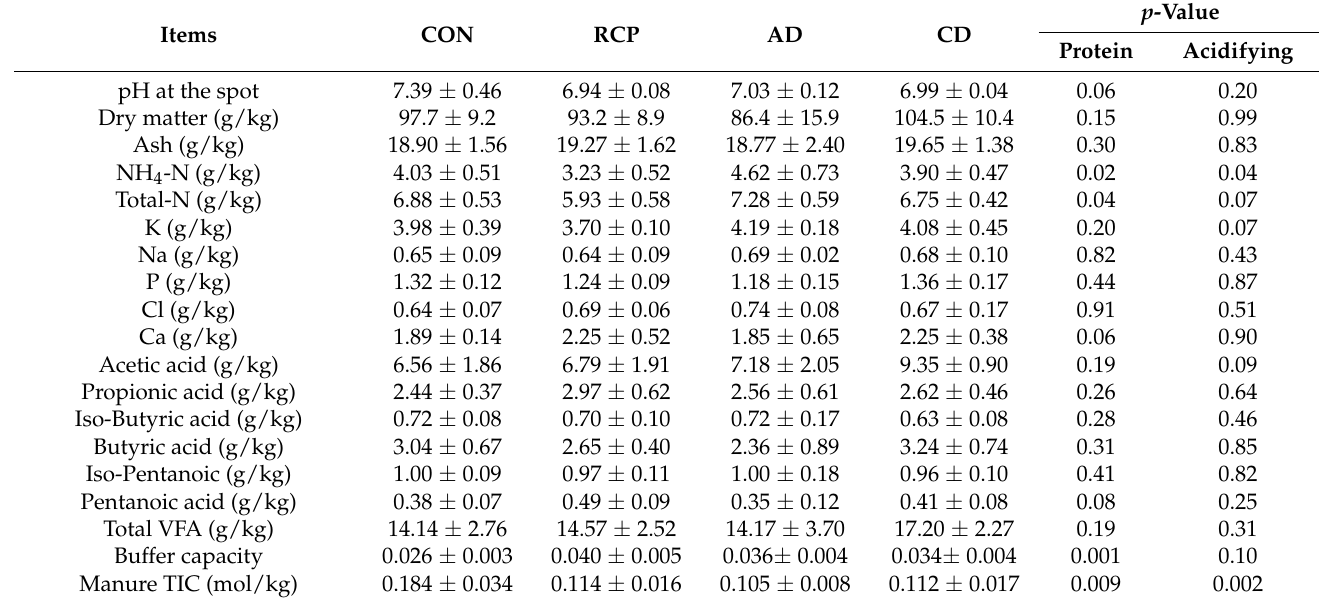
Table 6. Effects of experimental diets on manure characteristics (mean ± standard deviation, n = 4).